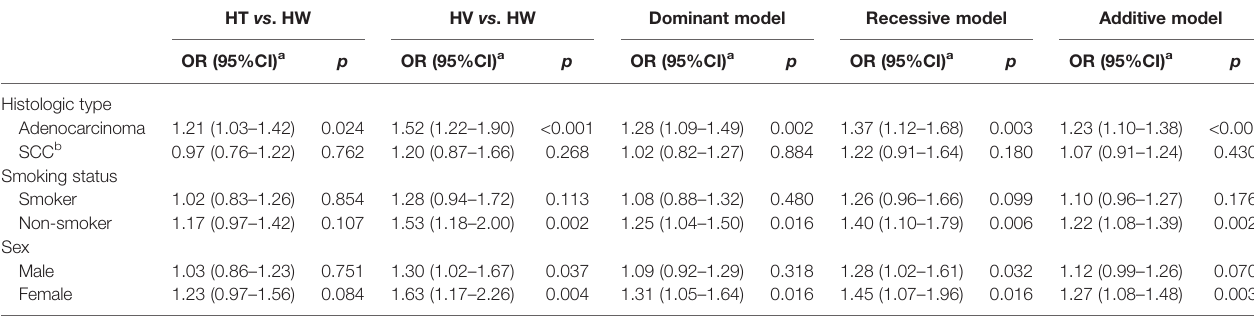
TABLE 4 | Subgroup analysis of SNP rs13064999 and NSCLC risk strati fi ed by histology, smoking status, and sex. HT vs . HW HV vs . HW